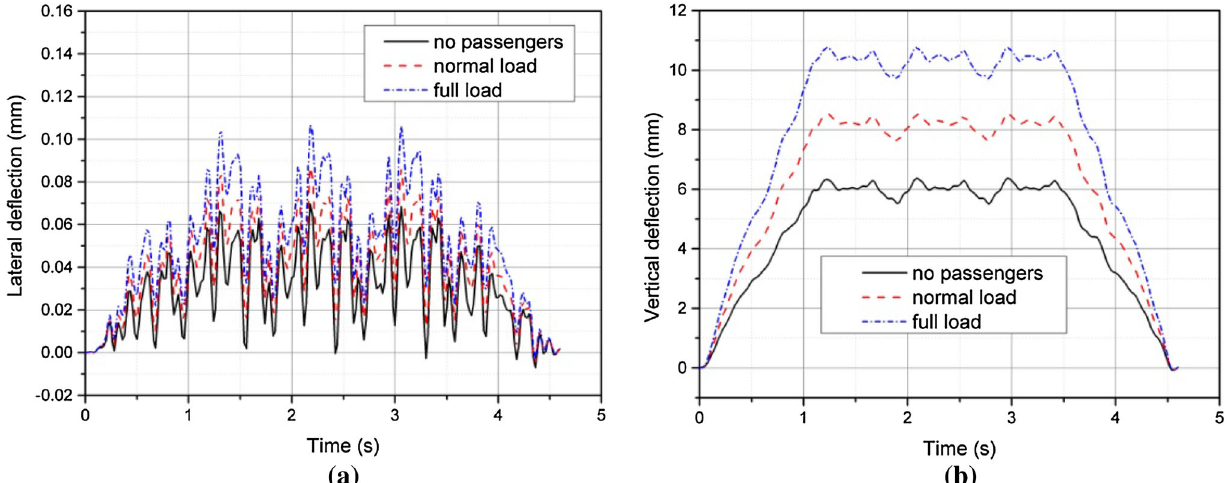
Fig. 11 Record of vibration displacement at middle span (unit: mm). a Lateral, b